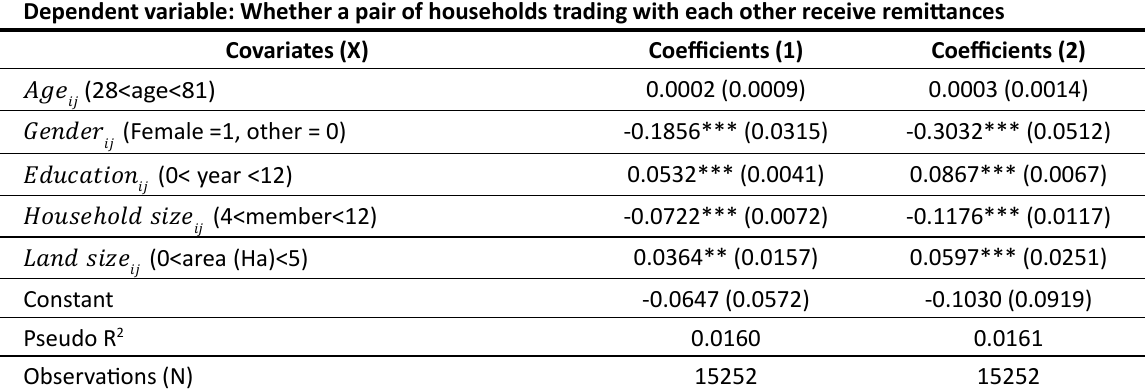
Table 5: Probit and Logit Estimation For Propensity